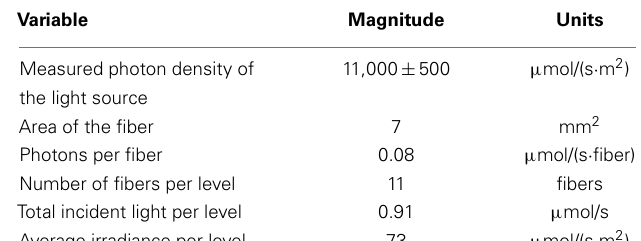
Table 1 | Light intensity calculations for the photobioreactor .